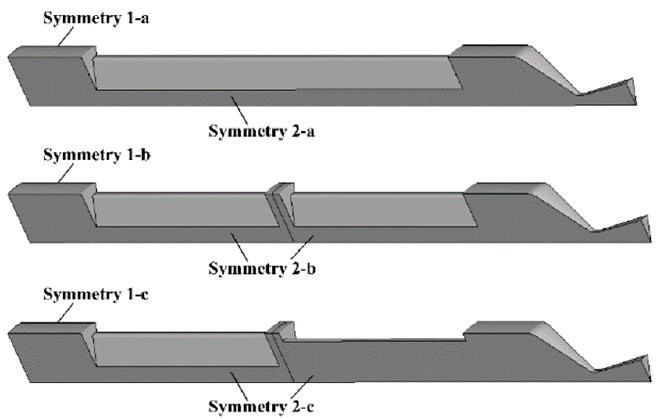
Figure 8. Schematic of symmetry planes in the computation domain.